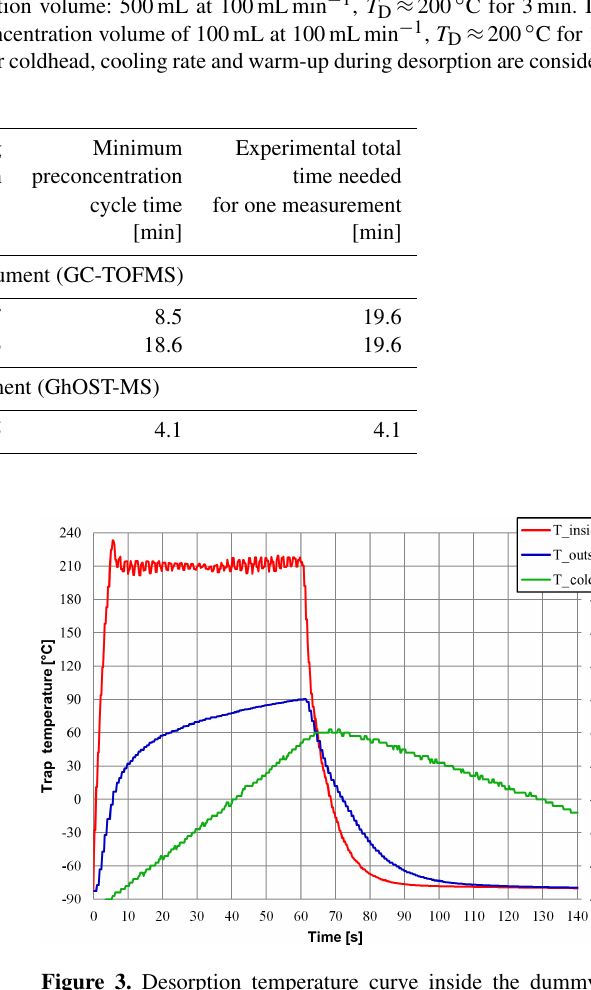
Figure 3. Desorption temperature curve inside the dummy trap (empty tube) with a preceding adsorption temperature of − 80 ◦ C and a subsequent cool-down from desorption to adsorption temper- ature. Left y axis: red curve represents T _inside_trap, the signal from temperature sensor shifted inside the trap; blue curve repre- sents T _outside_trap, the temperature sensor signal from the sensor welded to the outer trap tubing wall. Right y axis: green curve rep- resents T _coldhead, the temperature of the coldhead. Deterministic heater output in this example is 50% in stage 1, held for 5s, and 30% in stage 2, held for 55s. The periodic oscillation of T D ob- served is a result of a very slow pulse-width modulation used in the testing set-up: 100 ms period with 10ms minimum